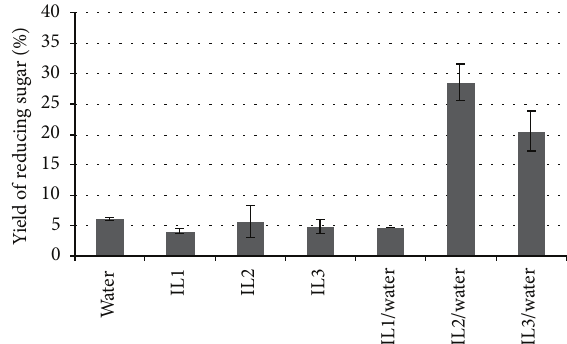
Figure 2: Yields of reducing sugar in the pretreatment. IL1: [BMIM]Cl/DMSO, IL2: [HMIM]Cl, and IL3: [HSO 3